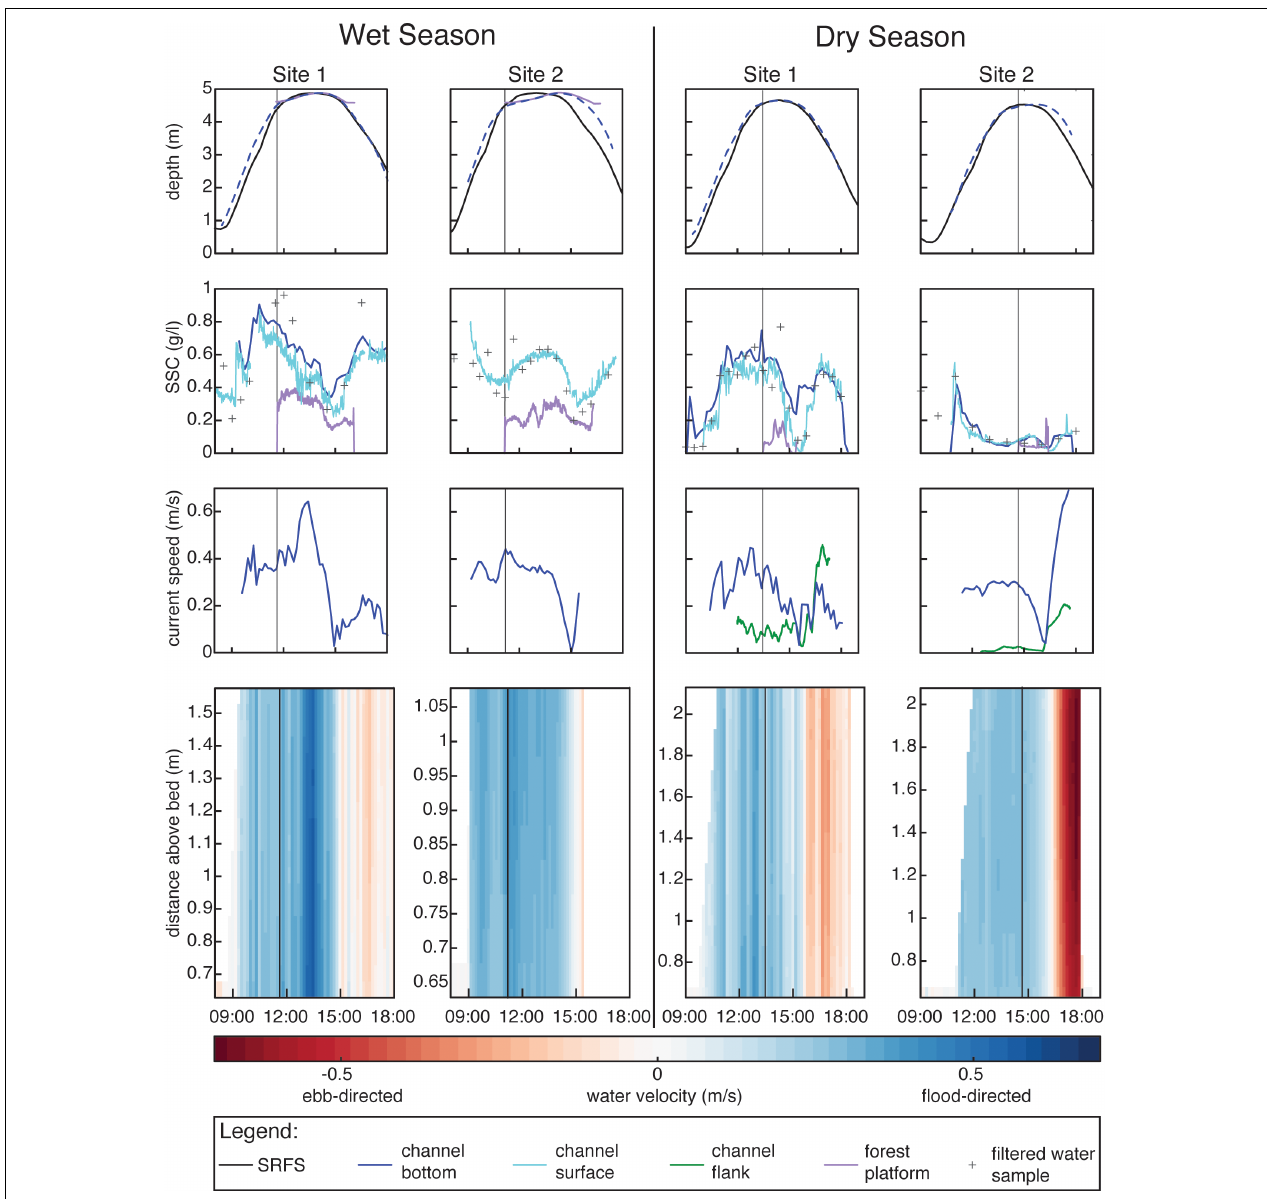
FIGURE 3 | Observations from the single-day experiments, including depth (relative to SRFS), SSC, and water velocity within the tidal channel. In general, we observe a decrease in both flood-oriented current velocity and SSC within the tidal channel from Site 1 to Site 2 (exterior to interior of the sub-basin), and from wet season to dry season. Vertical black line corresponds to the timing of platform inundation, as measured by the platform